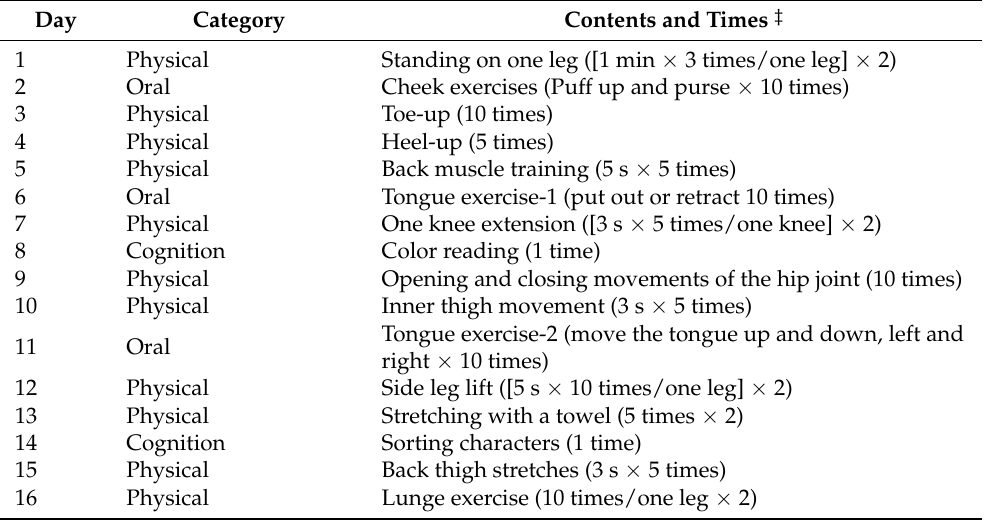
Table 1. Daily assignments for a month in the